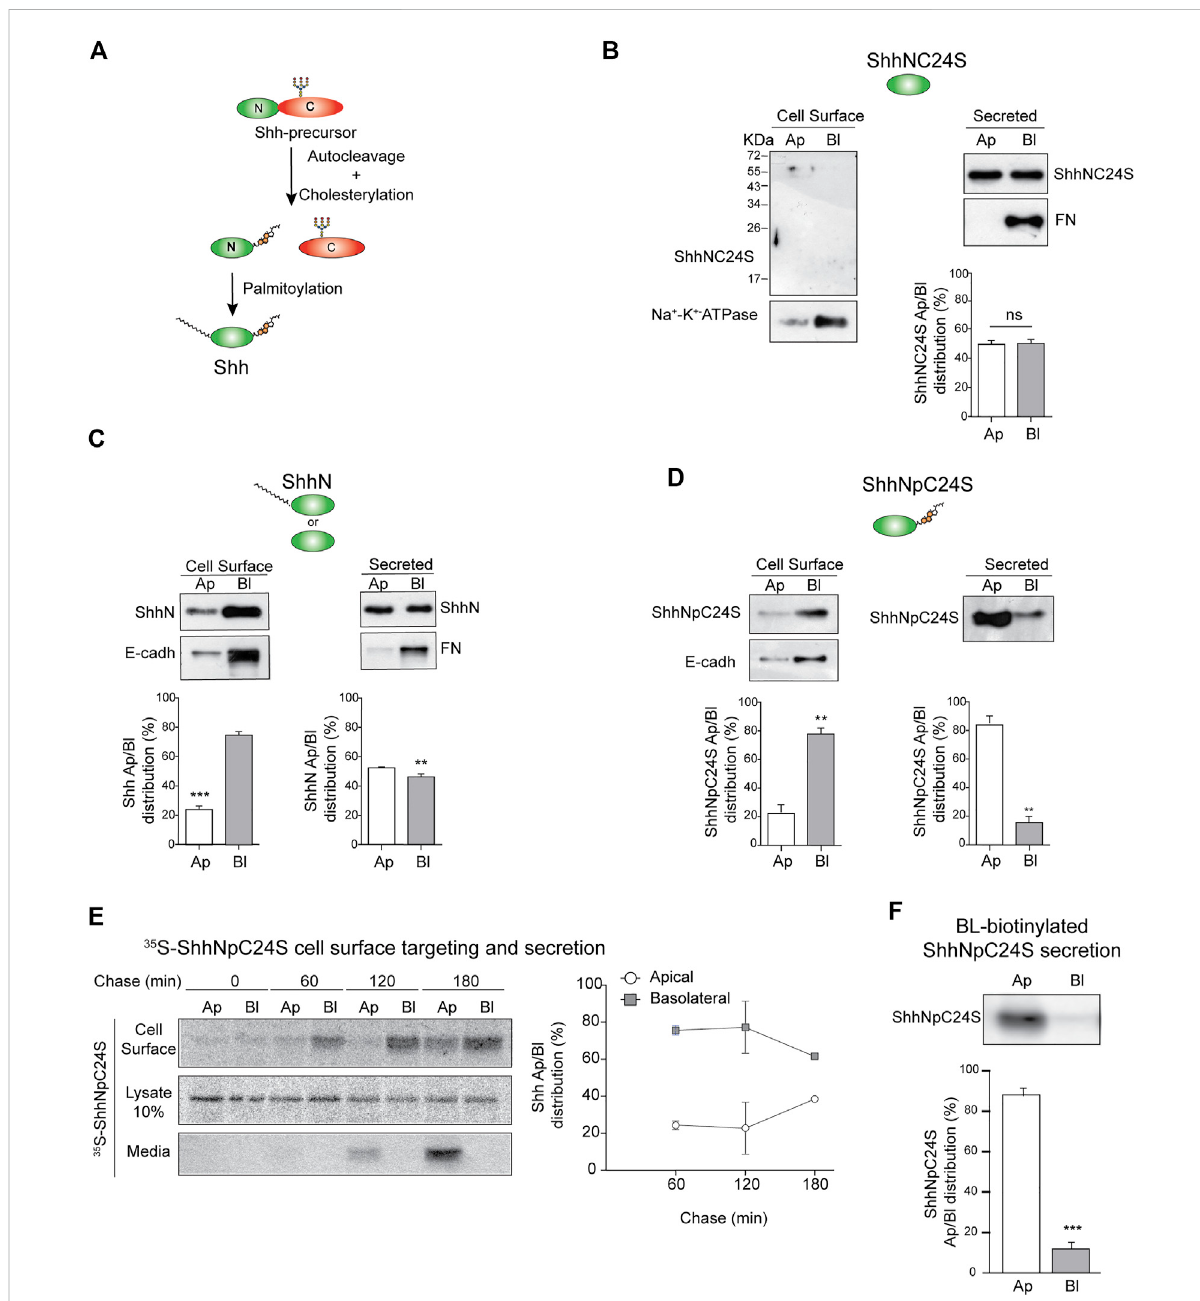
FIGURE 4 Sorting of Shh lipidation mutants. (A) Schematic Shh processing and lipidation. (B – F) Stable expression of MDCK cells indicated Shh lipidation mutants: lacking both lipids (ShhNC24S) (B) , only palmitoylated (ShhN) (C) , or only cholesteroylated (ShhNpC24S) (D) were analyzed by domain- speci fi c cell surface biotinylation and secretion. Basolateral E-cadherin and Na + /K + ATPase transmembrane proteins and secreted fi bronectin (FN) show cell polarity. (E) MDCK-ShhNpC24S cells were pulse-labeled with S 35 -methionine/cysteine and chased to detect protein arrival to each cell surface along with its polarized secretion. Graph shows the mean±SEM from two independent experiments. (F) Secretion of transcytosed ShhNpC24S.MDCK-ShhNpC24S cells biotinylated from thebasolateralside at4 ° C werethen incubated at37 ° Cfor 2 h,and immunoblot ofsecreted ShhNpC24S was performed on apical and basolateral conditioned media. Graphs of biotinylation and secretion assays (n = 3) represent mean±SEM. ** p < 0.05; *** p < 0.001, ns = no signi fi